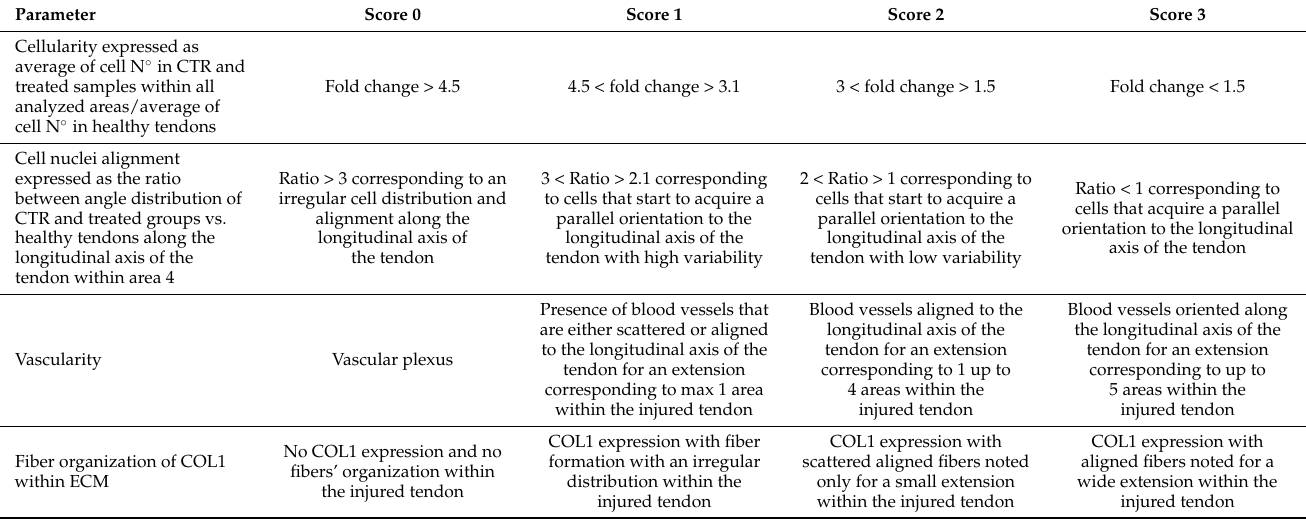
Table 3. Semiquantitative histomorphometric